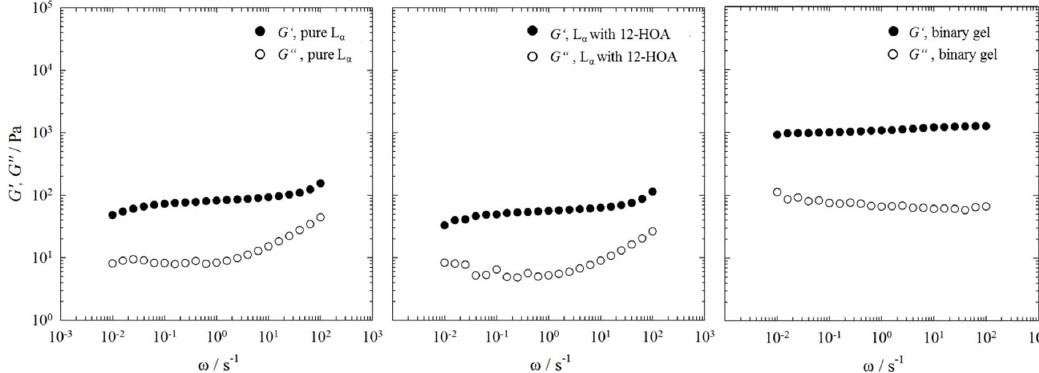
Figure 4. Storage modulus G’ and loss modulus G’’ (filled and open circles) of the pure lamellar phase L α at γ a = 0.76 ( left ), of the lamellar phase L α at γ a = 0.76 in presence of 12-HOA at η = 0.015 ( middle ), and of the binary gel n-decane–12-HOA at η = 0.015 ( right ) determined by frequency sweeps at T = 22 °C and a strain amplitude of γ = 1%.